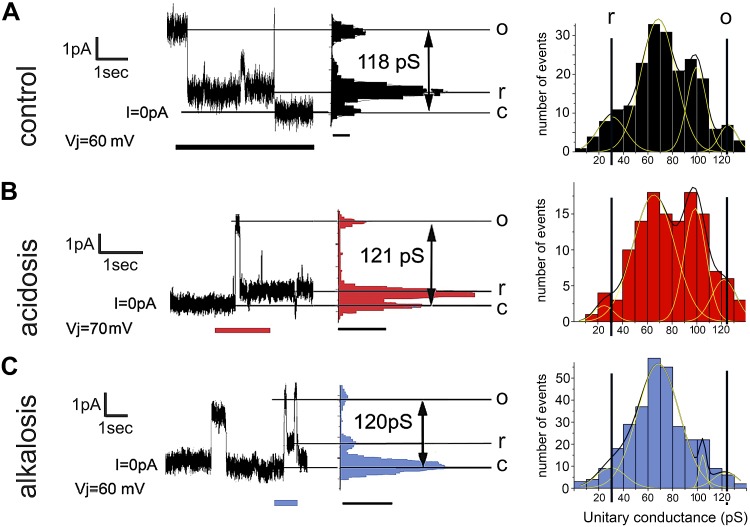
Effect of pHi on single-channel properties. A) Single-channel current recordings from Cx43-transfected HeLa cells measured in 2 mM halothane. Example time course shows rapid transitions from open to residual or closed states. Point-to-point histogram (middle) shows the fully open conductance (o) of 118 pS and a residual conductance (r) of 30 pS. All-event histogram (right) indicates the number of transitions between states. B). Single-channel recordings during the application of 80 mM acetate. Point-to-point histogram (middle) shows o = 121 pS and r = 30 pS. C) Single-channel recordings during the application of 20 mM TMA. Point-to-point histogram (middle) shows o = 120 pS and r = 30 pS. Unitary conductance measured in homotypic channels is not significantly different from previously reported values (120 pS). All-event histograms include peaks from transitions between fully open minus residual state (120−30 = 90 pS), and fully open channel transitions of phosphorylated states (60 pS).